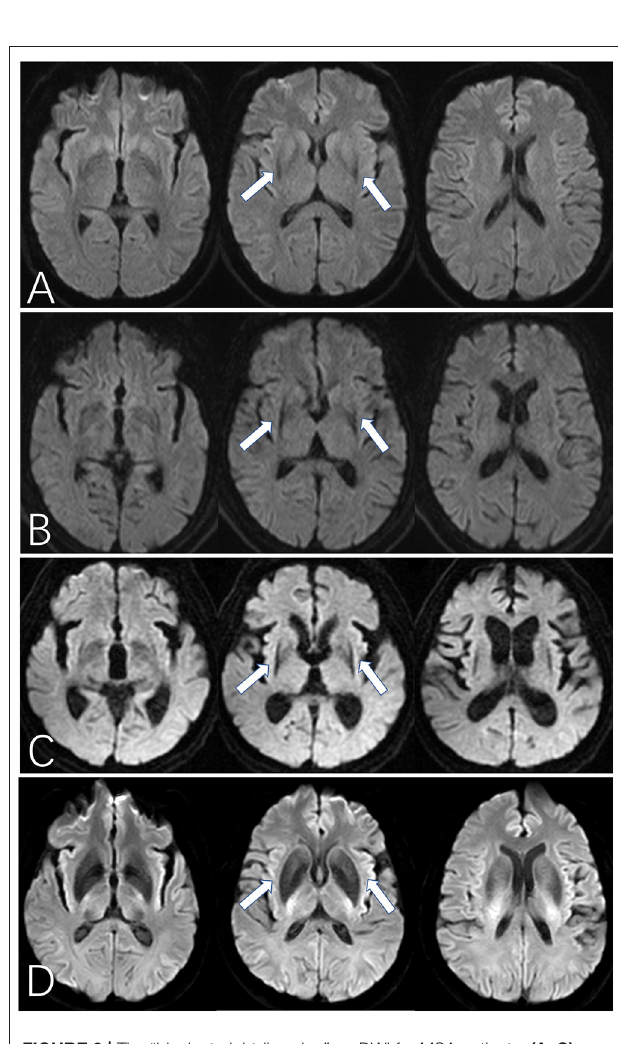
FIGURE 2 | The “black straight-line sign” on DWI for MSA patients. (A–C) show the “black straight-line sign” from mild to obvious, showing a linear, abnormally low signal with a clear border in the putamen (arrow). The most obvious section is at the fornix. The “black straight-line sign” can be asymmetric (B) or symmetric (C) . (D) shows the hypointense putamen signal distributed in an arc in a healthy control subject. MSA, multiple system atrophy. All illustrations are denoted as